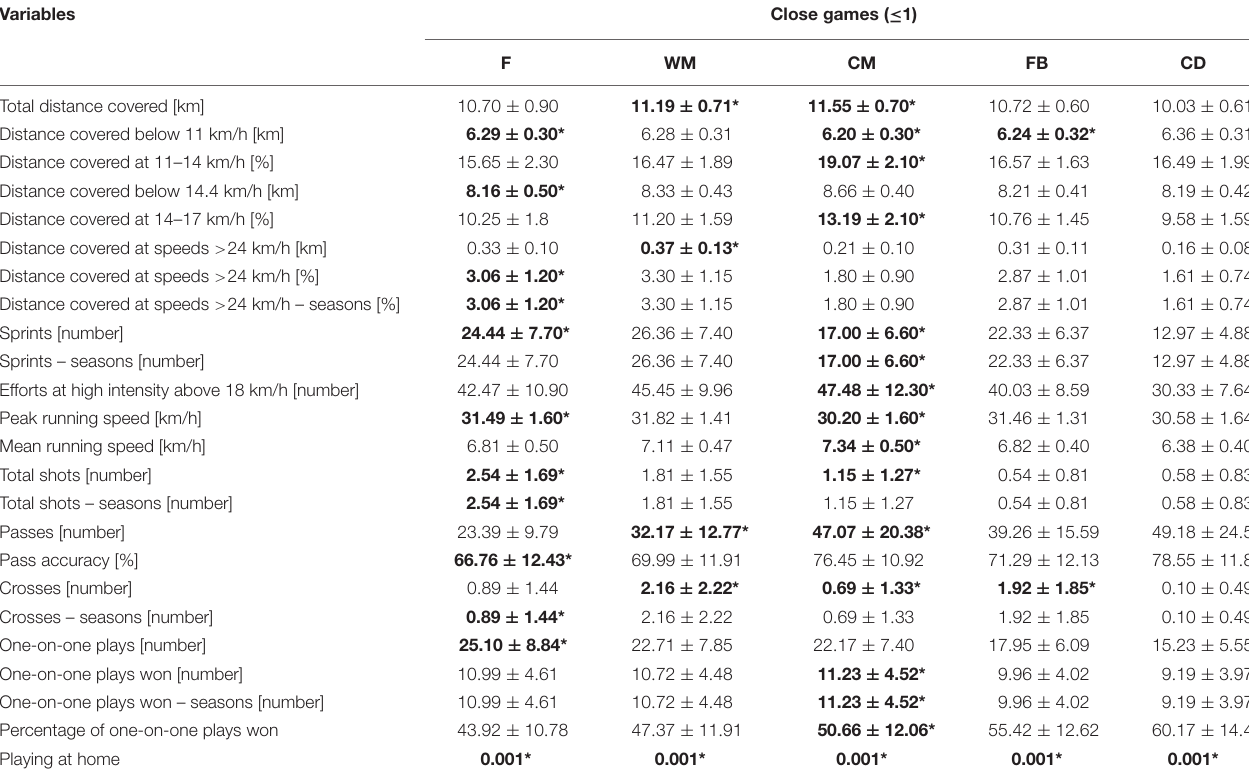
TABLE 1 | Physical and technical activities of players in different pitch positions in close games (means and SD).